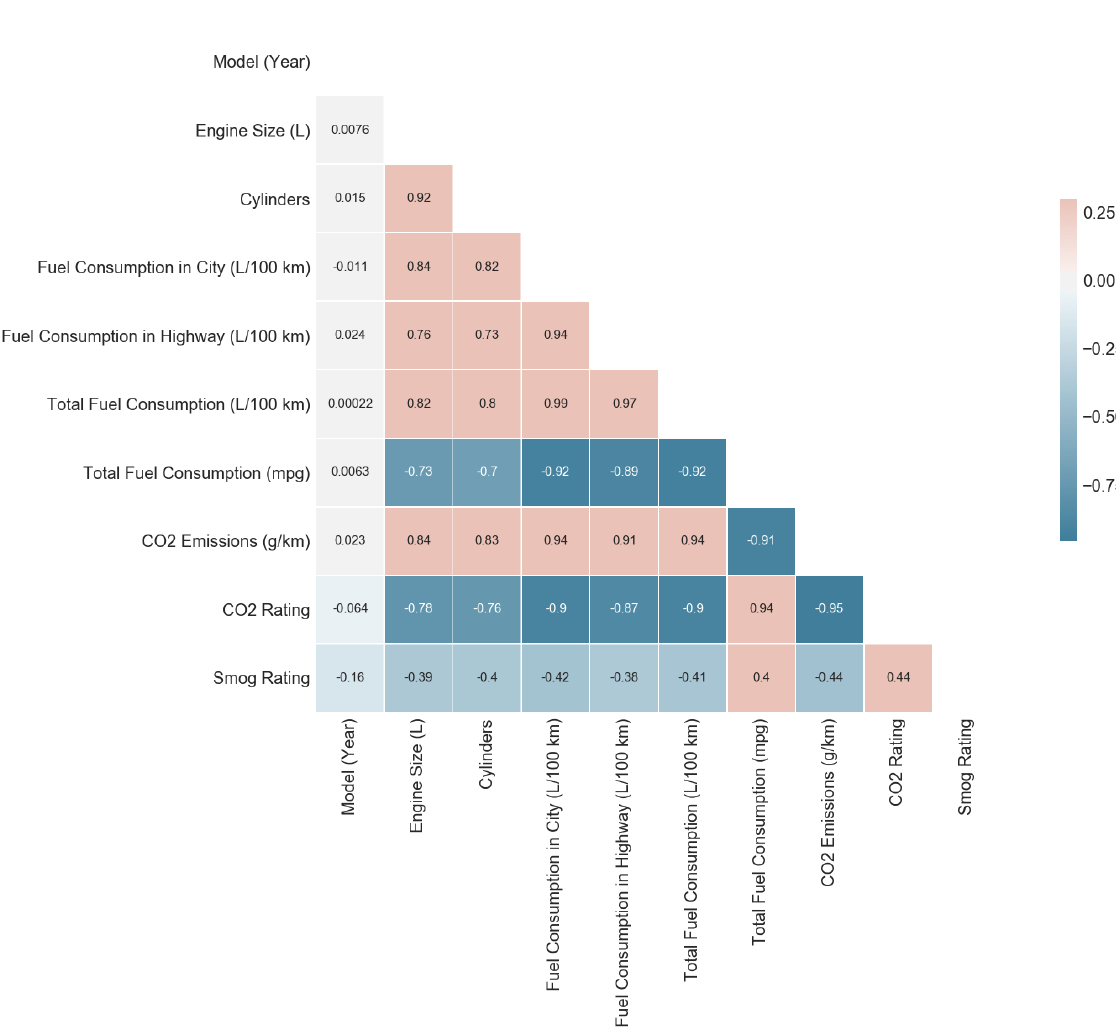
Figure 12. Heatmap of correlation between all dataset parameters.